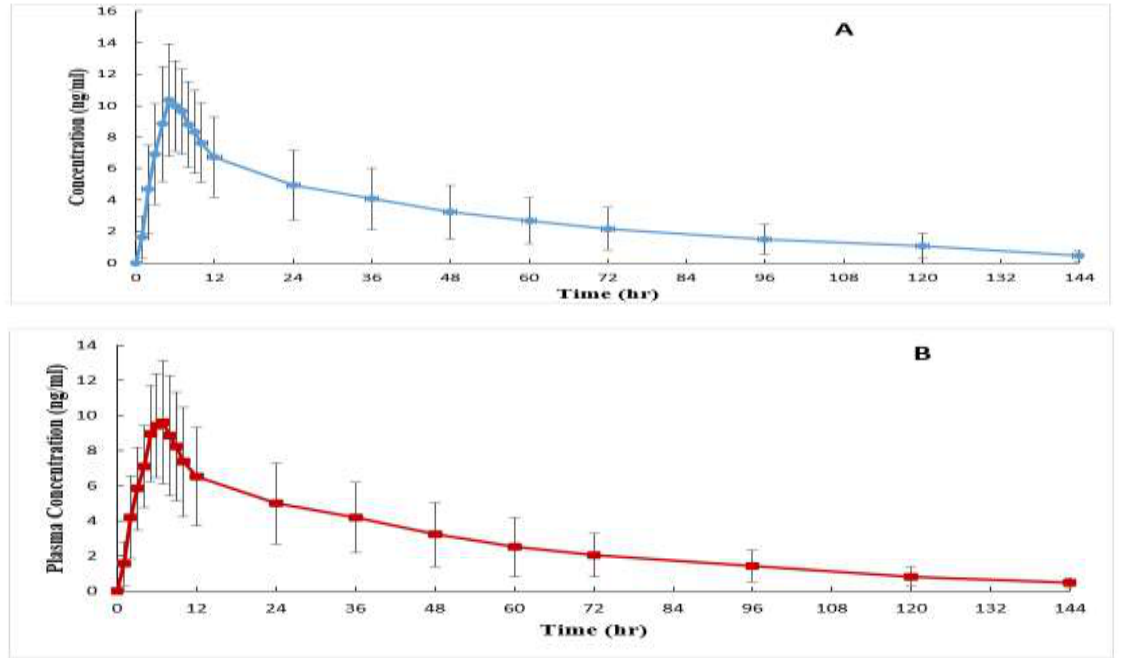
Figure 1. Plasma concentration-time profiles of fluoxetine after administering fluoxetine 20 mg capsules to healthy adult Arabic subjects under fasting (A) and fed (B) conditions (Each point is mean±SD , n=41 for each data